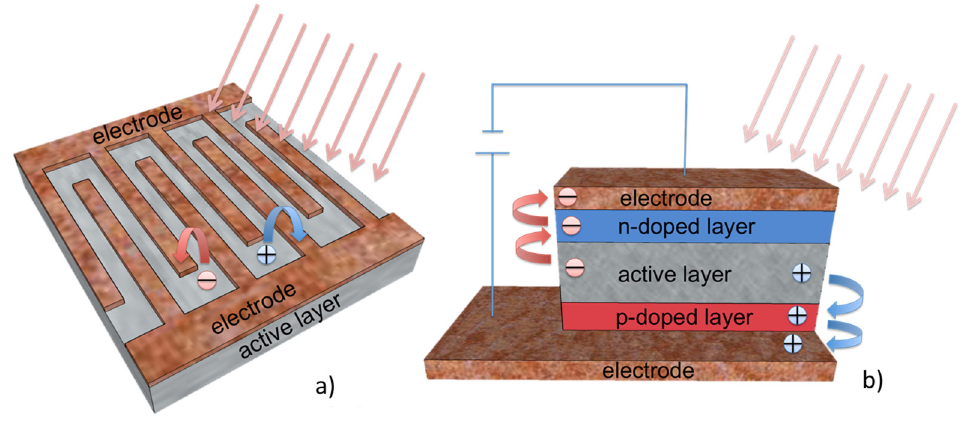
Figure 6. ( a ) Planar configuration and its basic working operation; ( b ) vertical configuration and its basic working operation.